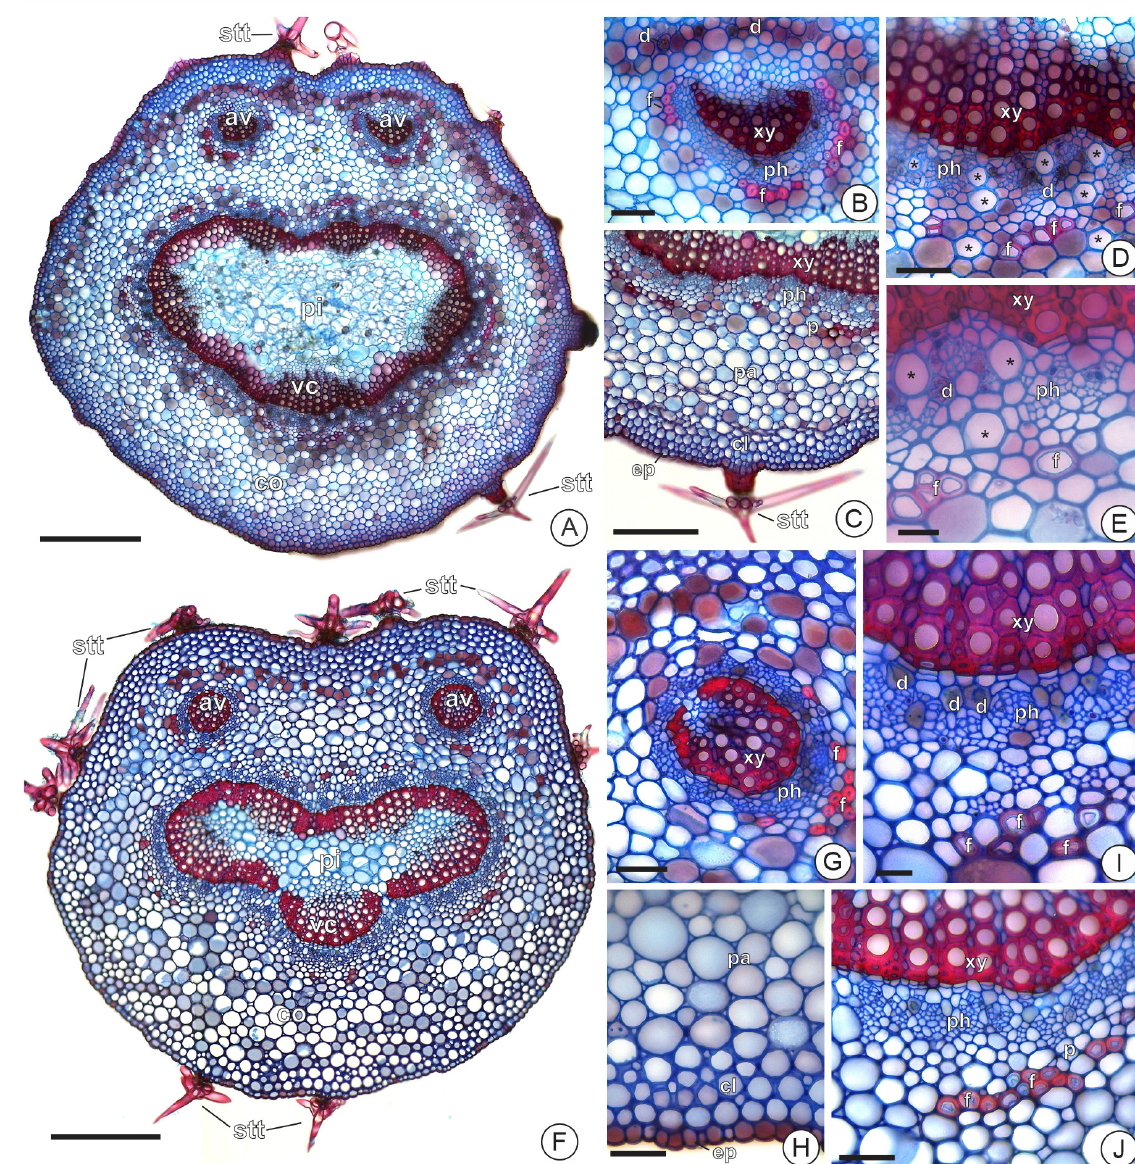
Fig. 7. Cross sections of the petiole of Croton echioides Baill. and C. sertanejus Sodré & M.J.Silva sp. nov. A–E . Croton echioides . A . Median portion of the petiole. B . Detail of accessory vascular bundles. C . Detail of the epidermis, cortex and vascular cylinder. D–E . Detail of vascular cylinder, laticifers, gelatinous fibers and druses. – F–J . C. sertanejus sp. nov. F . Median portion of the petiole. G . Detail of accessory vascular bundles. H . Detail of the epidermis and cortex. I–J . Detail of vascular cylinder, gelatinous fibers and druses. Asterisks indicate laticifers. Abbreviations: av = accessory vascular bundles; cl = collenchyma; co = cortex; d = druses; ep = epidermis; f = gelatinous fibers; p = pericycle; pa = ground parenchyma; ph = phloem; pi = pith; stt = stellate trichome; vc = vascular cylinder; xy = xylem. A–E = R.C. Sodré et al. 3284 (BOTU); F–J = R.C. Sodré et al. 3350 , holotype (BOTU). Scale bars: A, F = 300 µm; B–D, G–H, J = 50 µm; C = 200 µm; E, I = 20